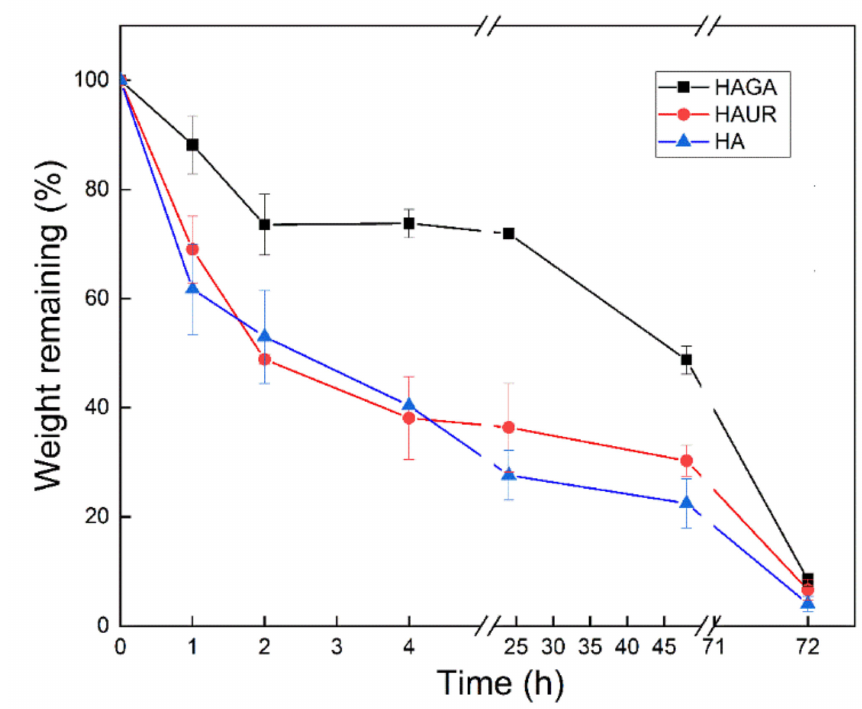
Figure 9. Biodegradation of microparticles formed from native (HA) and crosslinked (HAGA and HAUR) HA. Bars represent standard error of the